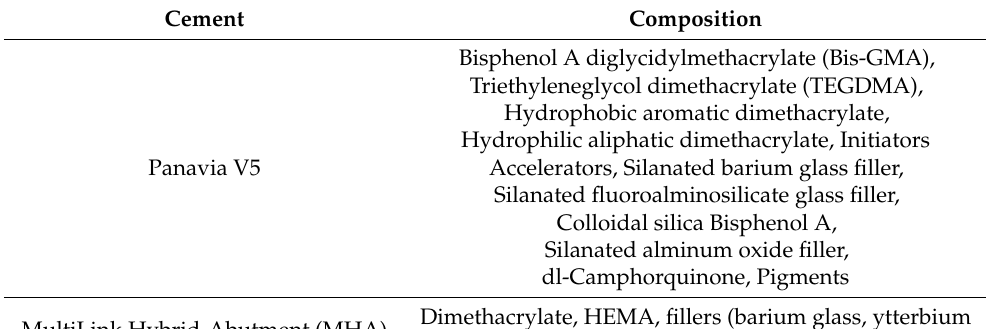
Table 1. The chemical composition of the cements.